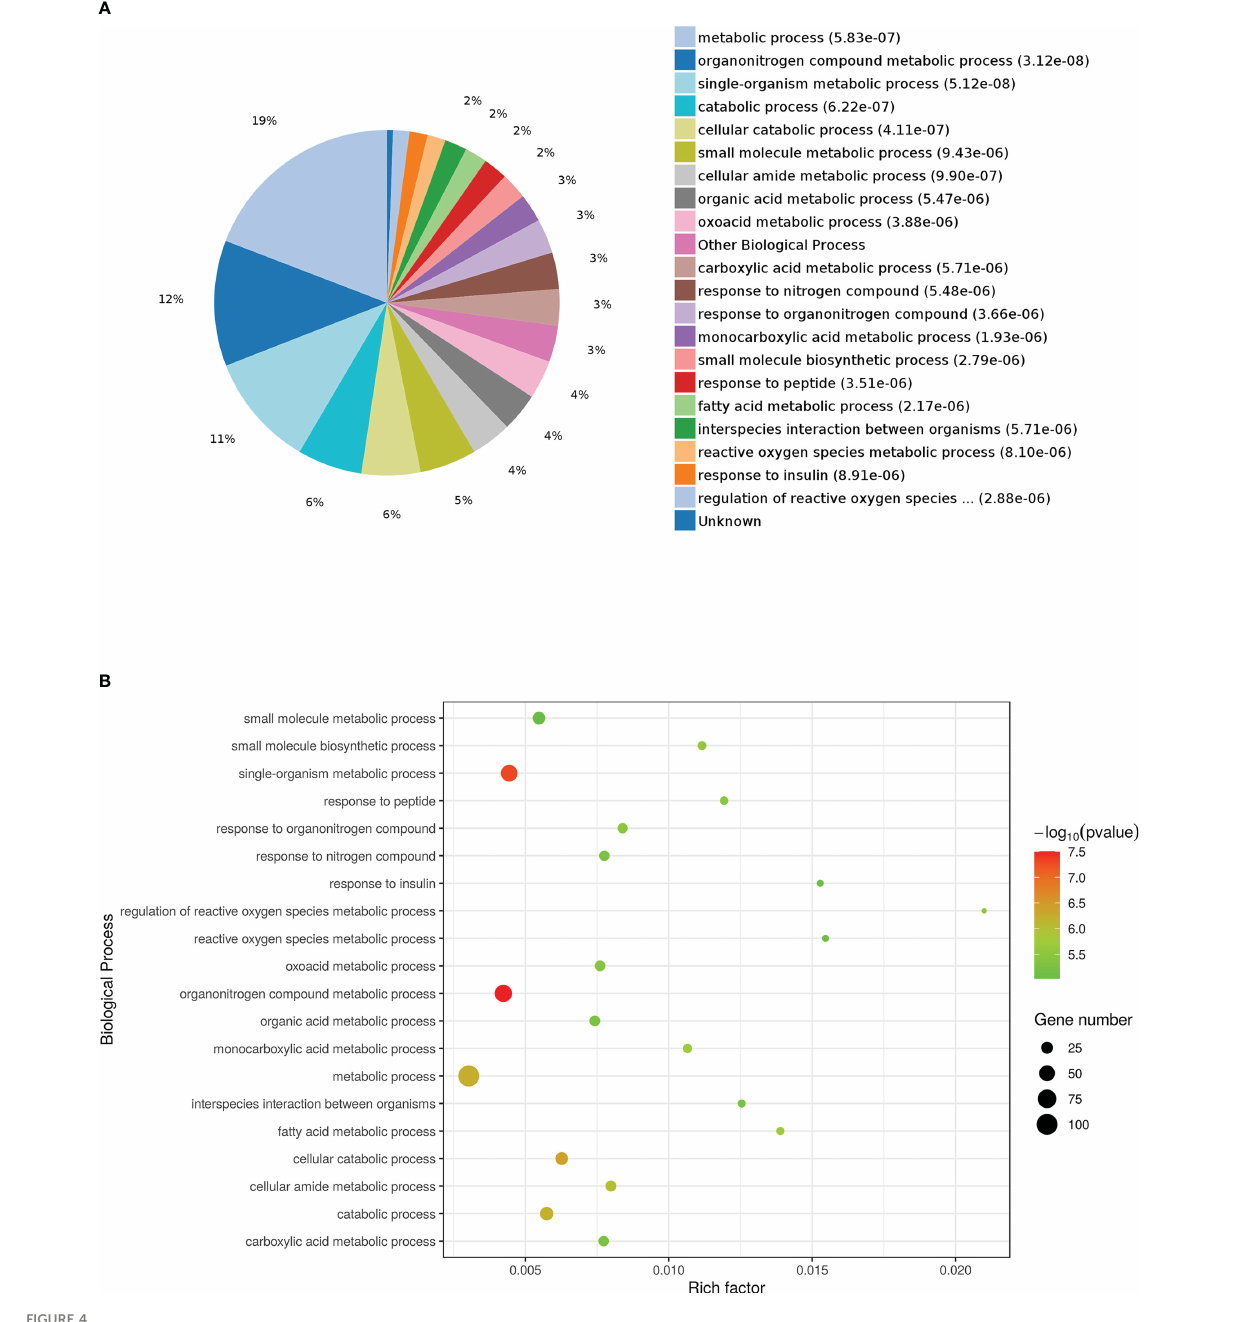
FIGURE 4 Gene Ontology (GO) enrichment analysis of biological processes for DEPs. (A) Pie chart of DEP-enriched GO terms for biological processes (bp). (B) Enriched GO terms for